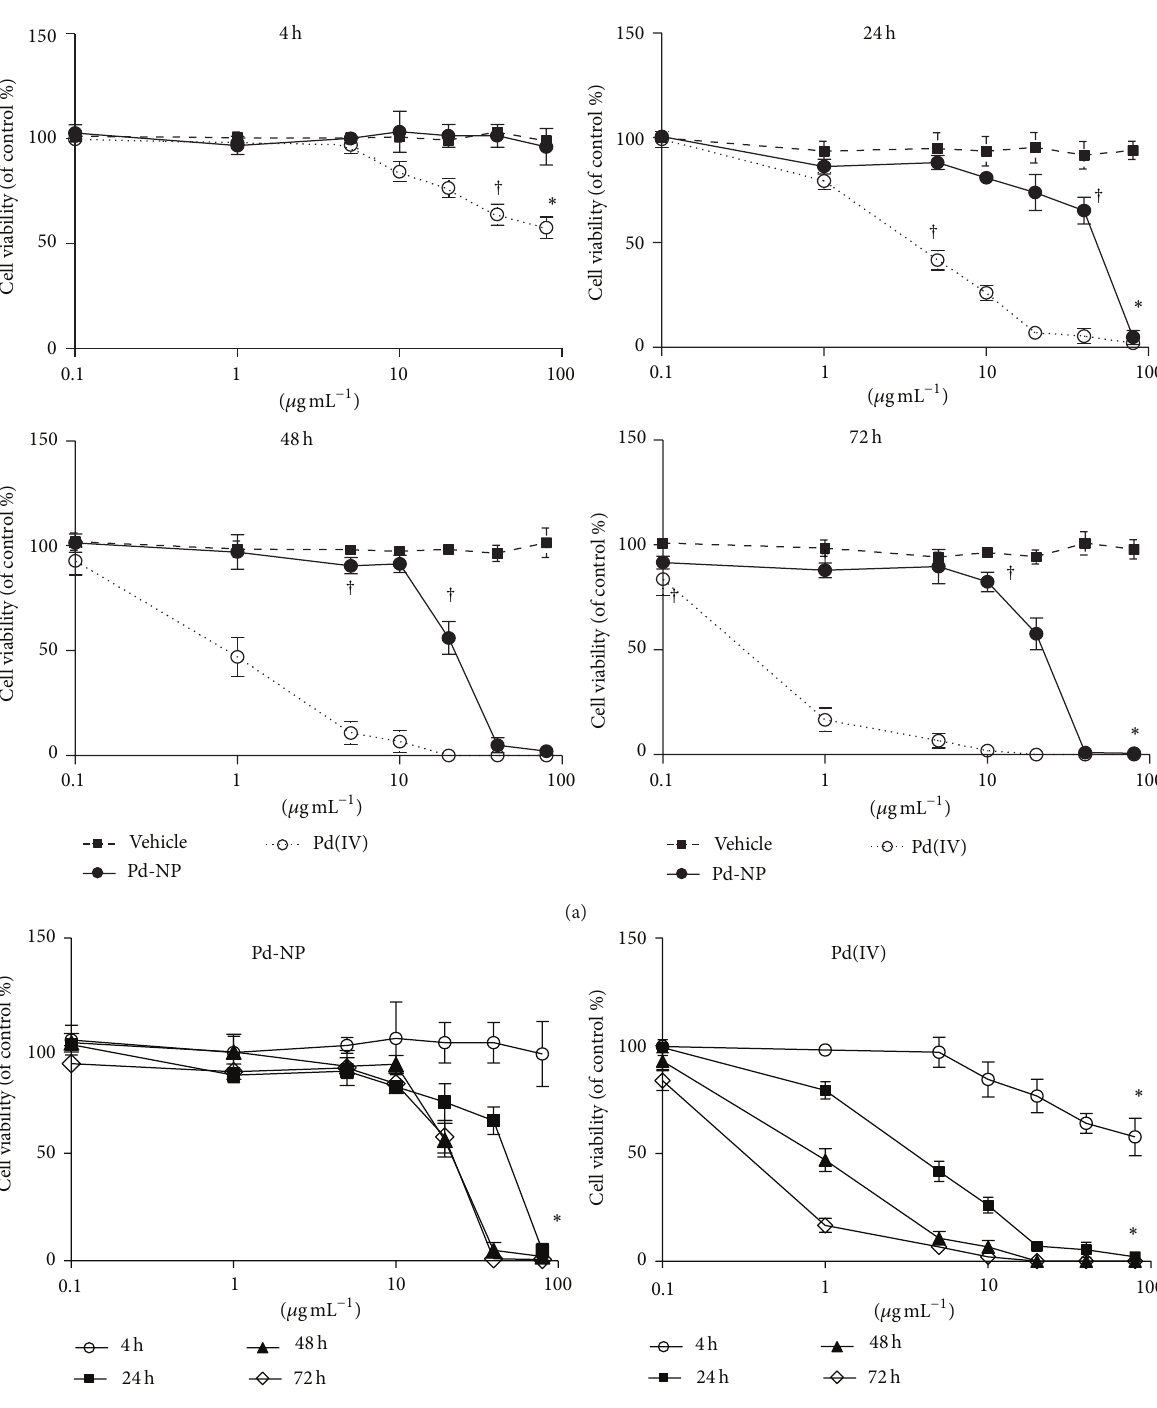
Figure 1: Evaluation of in vitro cytotoxicity by MTT assay. Different concentrations of Pd-NP (circles) (0.1, 1, 5, 10, 20, 40, and 80 𝜇 g mL −1 ) or Pd(IV) ions (open circles) were added to PHA-stimulated PBMCs from healthy donors ( 𝑛 = 3 ) on the 3rd day of culture, in quadruplicate wells. As reference, parallel control wells were set by adding the vehicle alone (culture medium, 10% FCS) (squares). The extent of cell growth was measured after 4, 24, 48, and 72 hours of incubation. The vehicle did not significantly affect cell viability. (a) Data comparing the different compounds (vehicle, Pd-NP, and Pd(IV)) are plotted in logarithmic scale and shown as mean ± S.D., as a function of concentration. (b) Data comparing the incubation time for Pd(IV) and Pd-NP are plotted in logarithmic scale and shown as mean ± S.D., as a function of concentration. The differences in cell viability related to Pd(IV) versus vehicle reached statistical significance ( 𝑃 < 0.05 ) starting from the following concentration/time exposure combinations: 40 𝜇 gmL −1 after 4 hours, 5 𝜇 g mL −1 after 24h, 1 𝜇 g mL −1 after 48 h, and 0.1 𝜇 gmL −1 after 72 h. Pd-NP-induced cytotoxicity was statistically significant ( 𝑃 < 0.05 ) versus vehicle for the following conditions: 80 𝜇 gmL −1 after 24 h, 20 𝜇 gmL −1 after 48 h, and 10 𝜇 g mL −1 after 72 h. ∗ 𝑃 < 0.001 three-way ANOVA with Tukey correction, † 𝑃 < 0.05 𝑡 -tests Pd-NP and Pd(IV) vs not